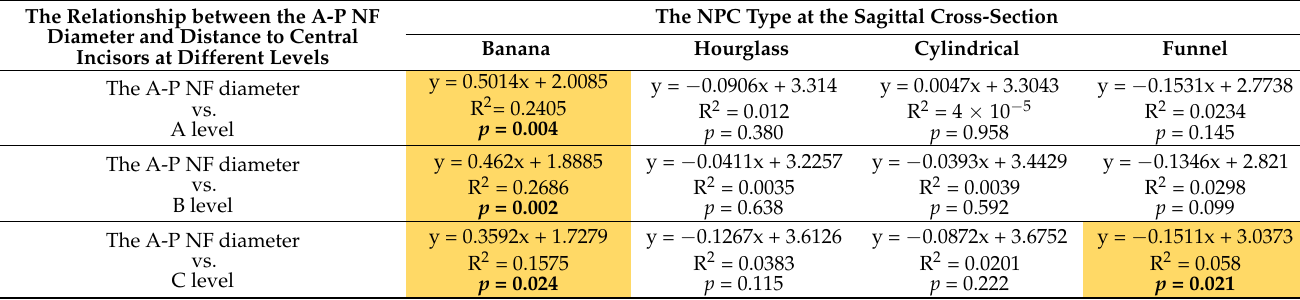
Table 6. Relationship between NPC length and distance to central incisors at different levels according to NPC type. The NPC Type at the Sagittal Cross Section The Relationship between the NPC Length Diameter and Distance to Banana Hourglass Cylindrical Central Incisors at Different Levels